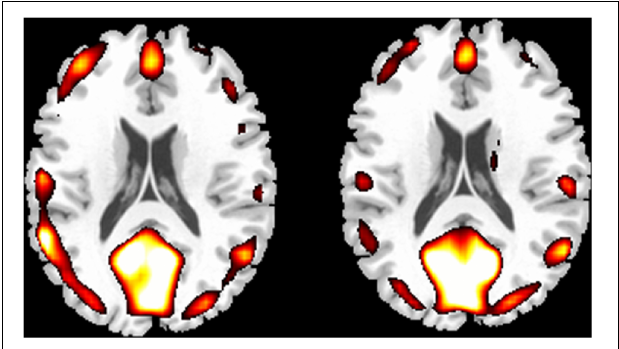
FIGURE 1 | One-sample results for novices (left column) and professional Chinese chess players (PCCPs) (right column). The regions indicated by a warm color showed greater regional homogeneity (ReHo). The threshold was P < 0.01, FDR corrected. The left side of the image corresponds to the left side of the